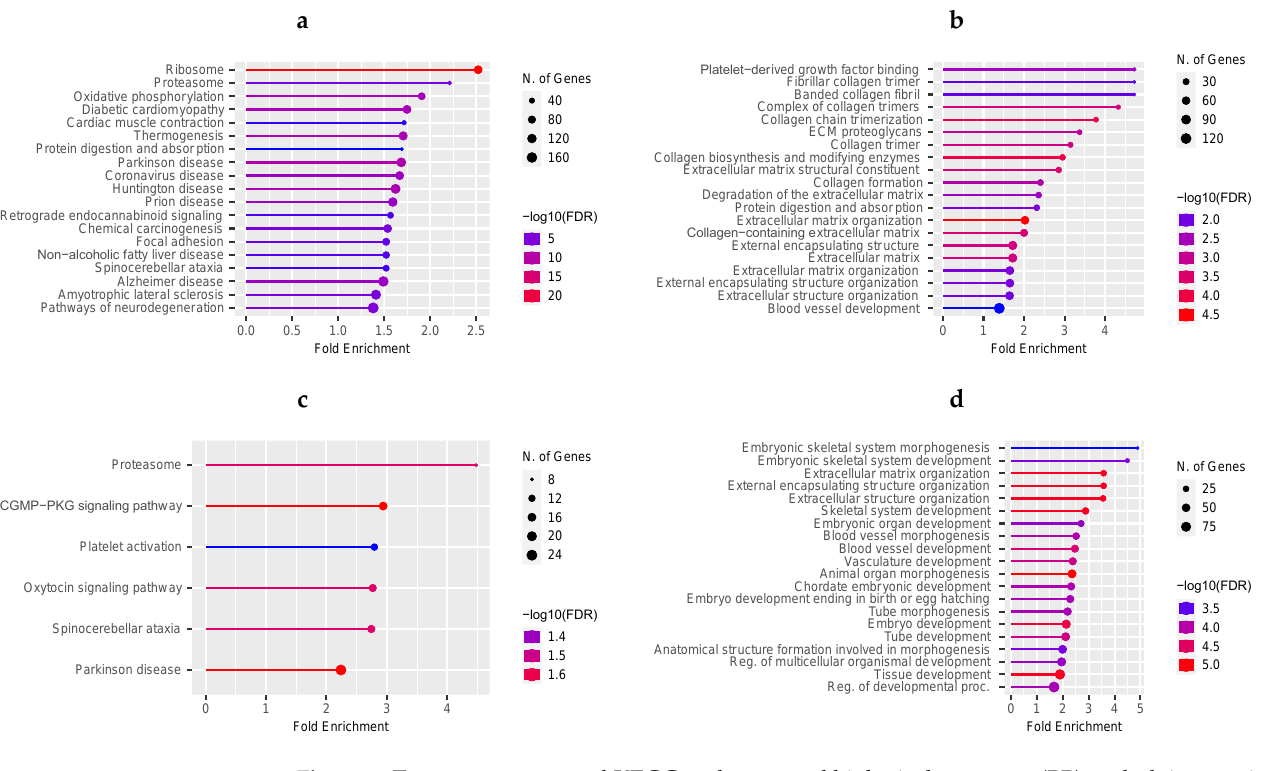
Figure 4. Top over-represented KEGG pathways and biological processes (BP) underlying uterine luminal epithelial co-expressed genes. KEGG pathways from the individual network of co-expressed genes from pregnant ( a ) and non-pregnant cows ( b ); BP of individual subnetworks of genes co-expressed with the ENSBTAG00000019474 gene from pregnant ( c ) and non-pregnant cows ( d ).